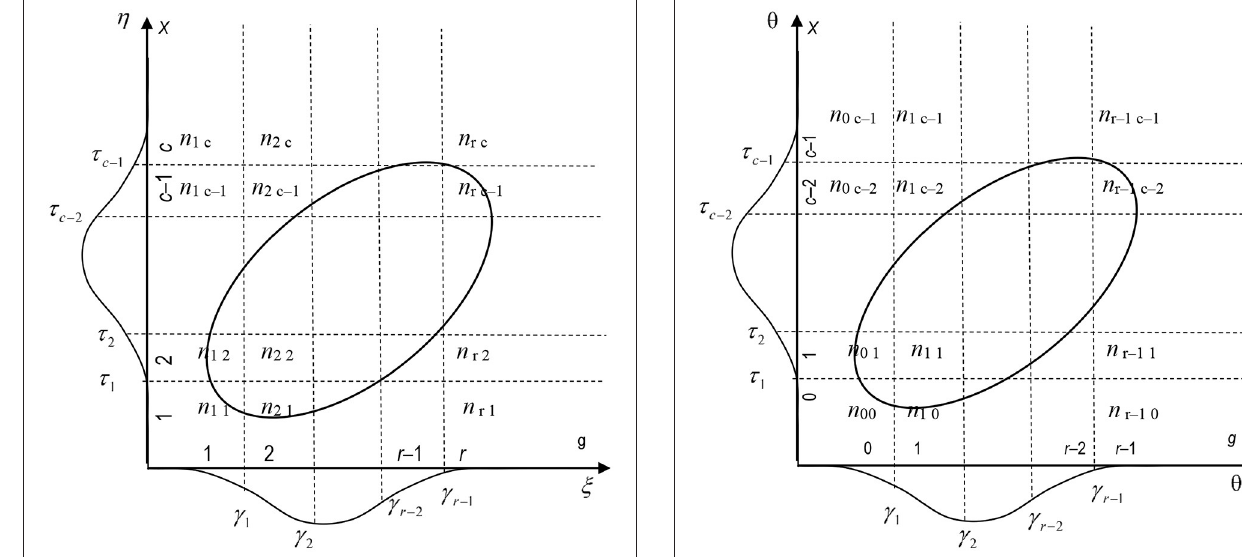
distinctive categories with metric properties (ordinal, interval, pseudo-continuous 1 or continuous scales), respectively, and